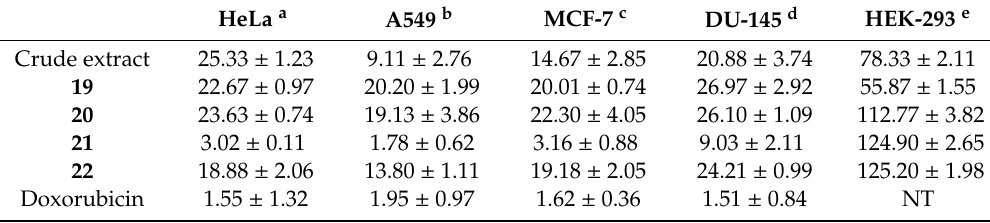
Table 1. IC 50 values for acetone extract and isolated compounds 19 – 22 on selected human cell